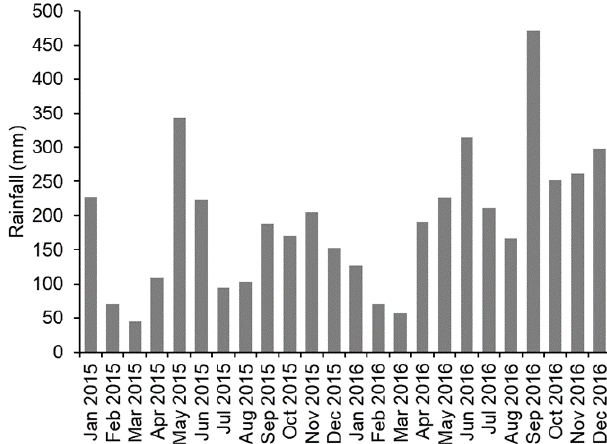
Figure 1. Monthly rainfall (mm) in the SAFE area in 2015 and 2016 (Rory